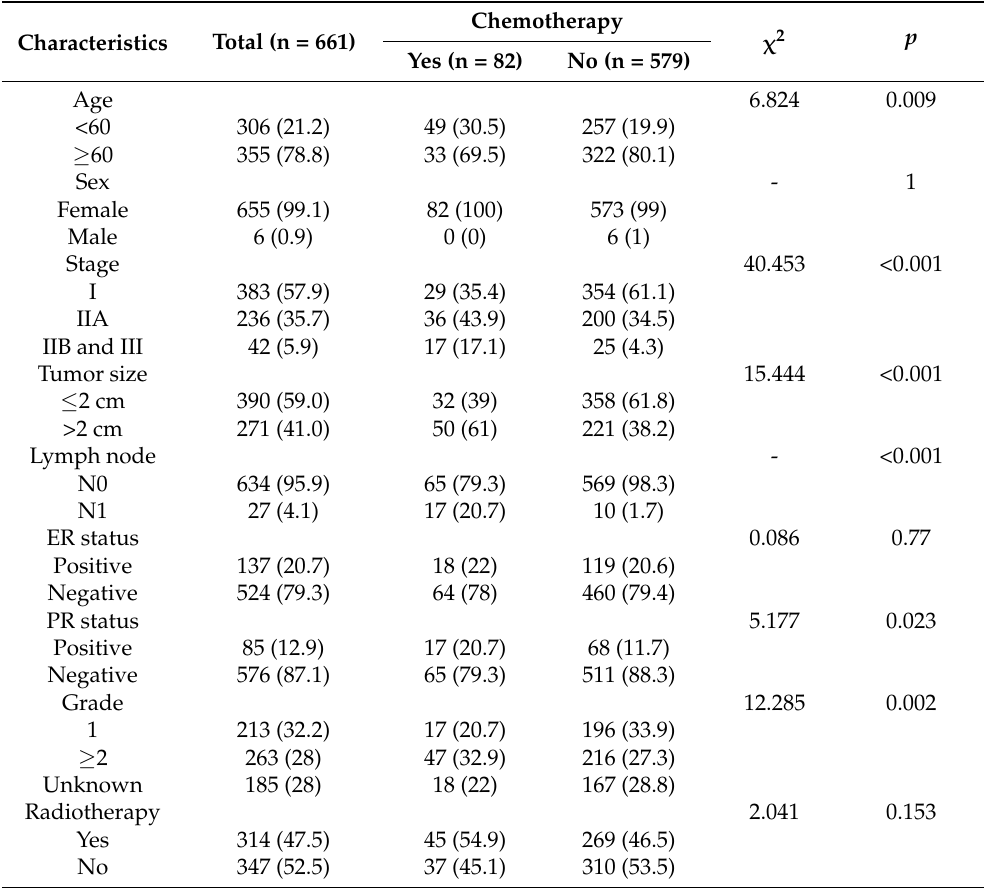
Table 1. Clinical characteristics of patients with ACCB in chemotherapy group and non-chemotherapy group in